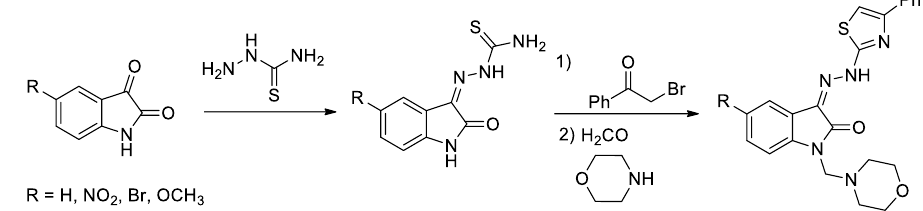
Figure 1. Reaction scheme for obtaining isatin-thiazole-derived compounds. The study was supported by FaF/8/2022